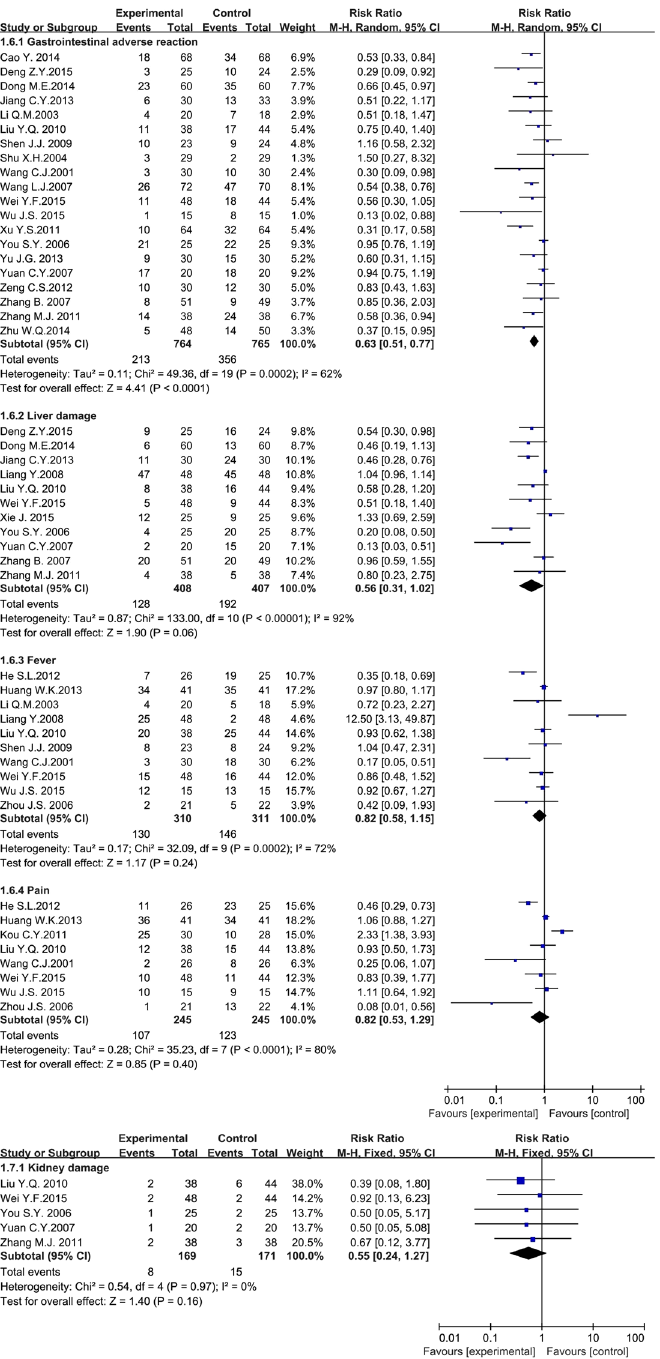
Figure 8. The forest plots of other side effects (gastrointestinal adverse reaction, liver damage, fever, pain and kidney damage) for traditional insect Chinese medicine and the related preparation combined chemotherapy versus chemotherapy alone ( M-H : Mantel-Haenszel estimates; CI : Confidence